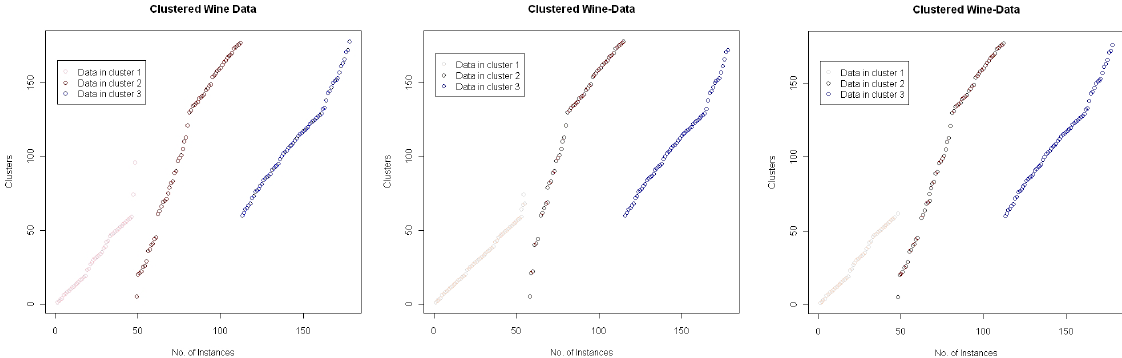
Fig. 19. Wine Dataset: (i) Result by KFCM (ii) Result by KEFCM wd (iii) Result by KFCM nt .